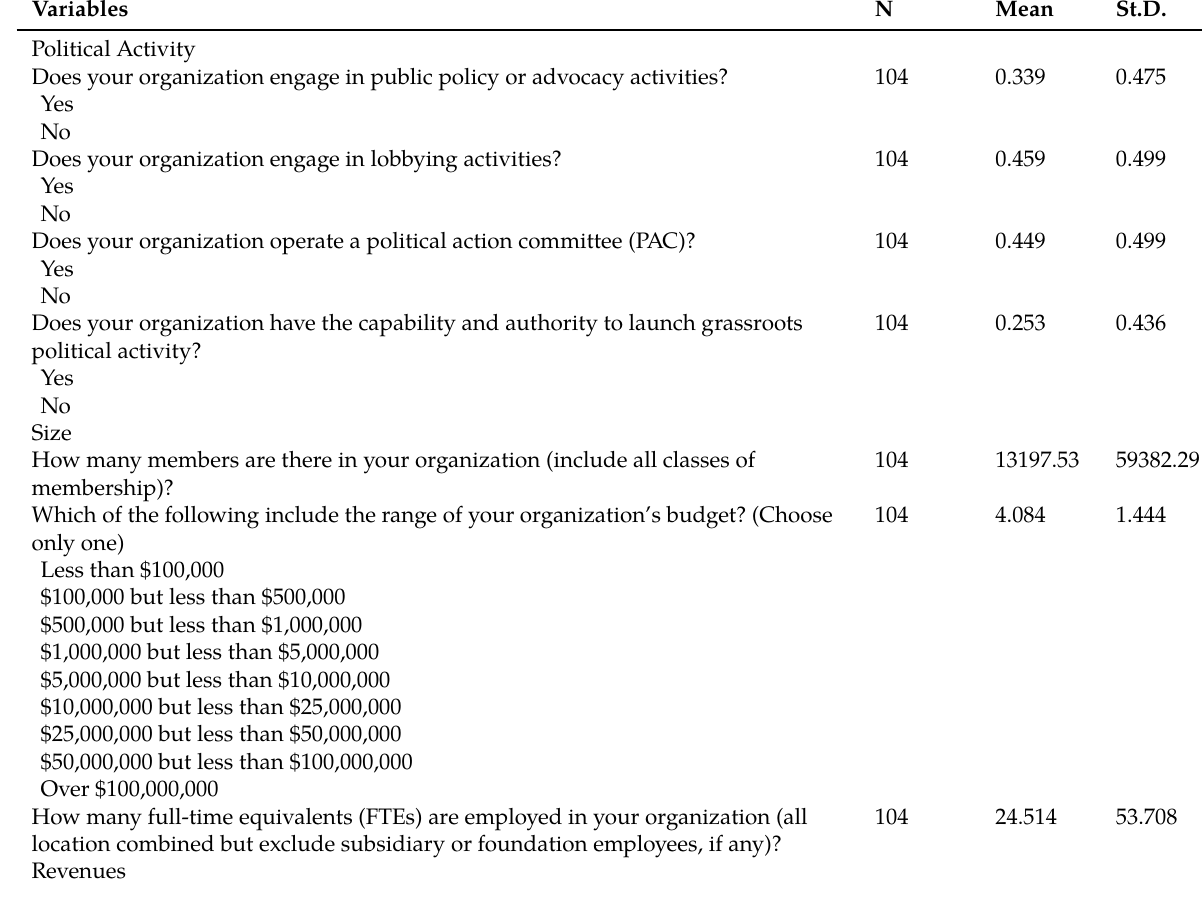
Table 1: Descriptive